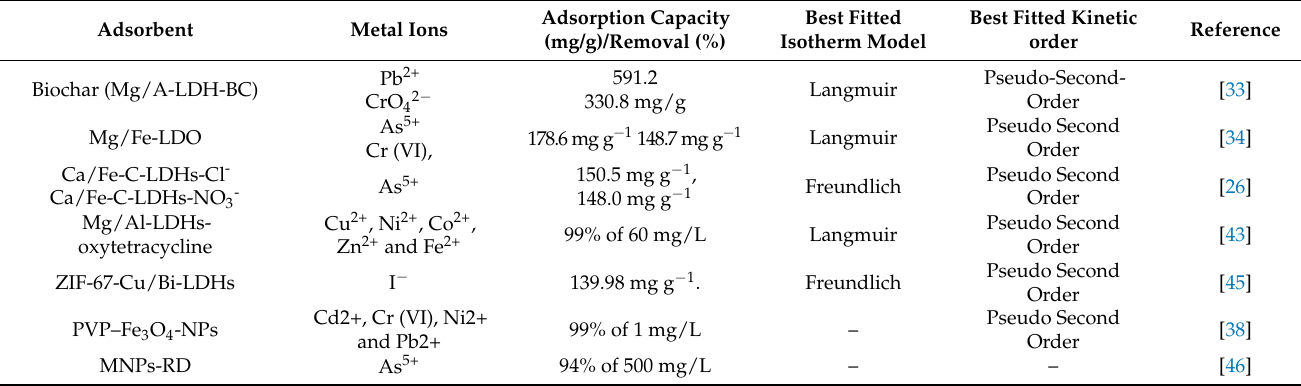
Table 2. Adsorption characteristics of various non-carbon